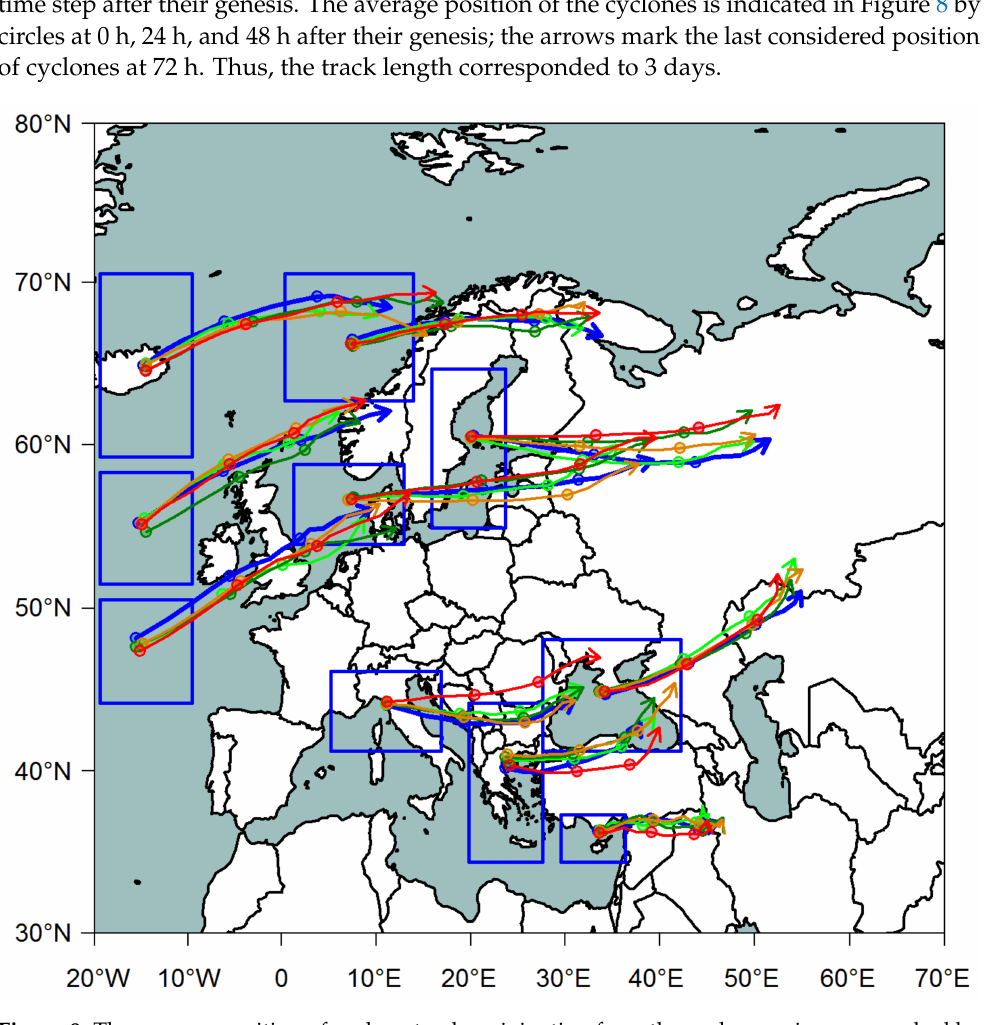
Figure 8. The average position of cyclone tracks originating from the cyclogenesis areas marked by blue rectangles. The blue track is for the period of the beginning of the century, the light green track is for the mid-21st century under the SSP2-4.5 scenario, the green track is for the end of the century under the SSP2-4.5 scenario, the orange track is for the mid-21st century under the SSP5-8.5 scenario, and the red track is for the end of the century under the SSP5-8.5